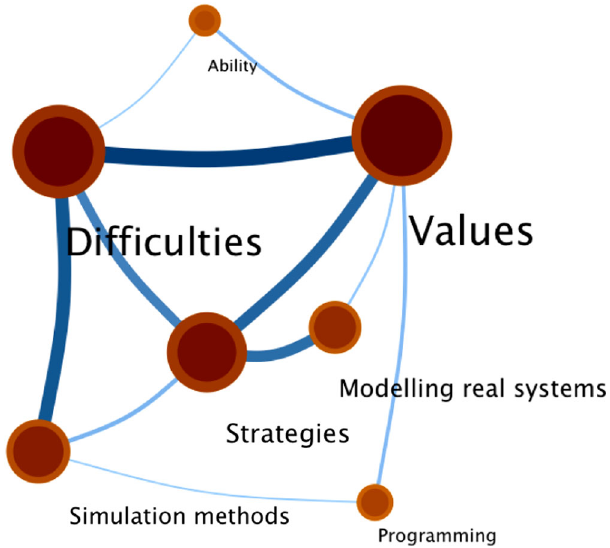
FIG. 4 (color online). Simplified networks after the problem- solving task. The size of each module corresponds to the importance of the module in the network, i.e., how much focus students put on associating between epistemic elements within that module, and the width of each link represents the informa- tion flow between modules. This network captures 95% of the node flow and 83% of the link